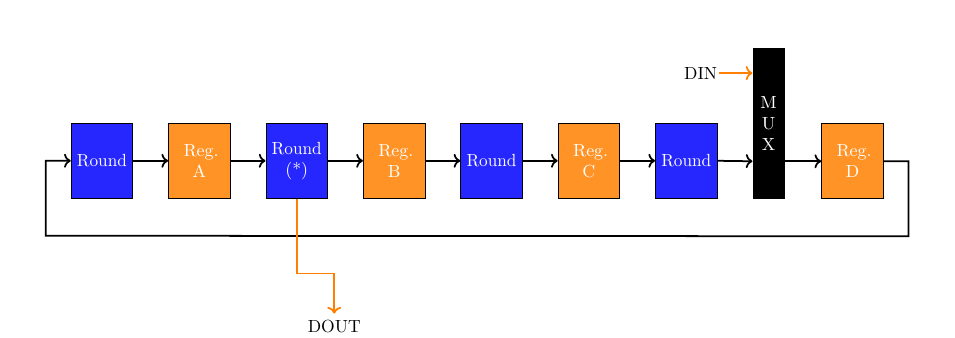
Figure 3: Presumable AES architecture of the analyzed hardware IP. Four rounds are processed in parallel, each result is stored in one of four state registers before passed to the next